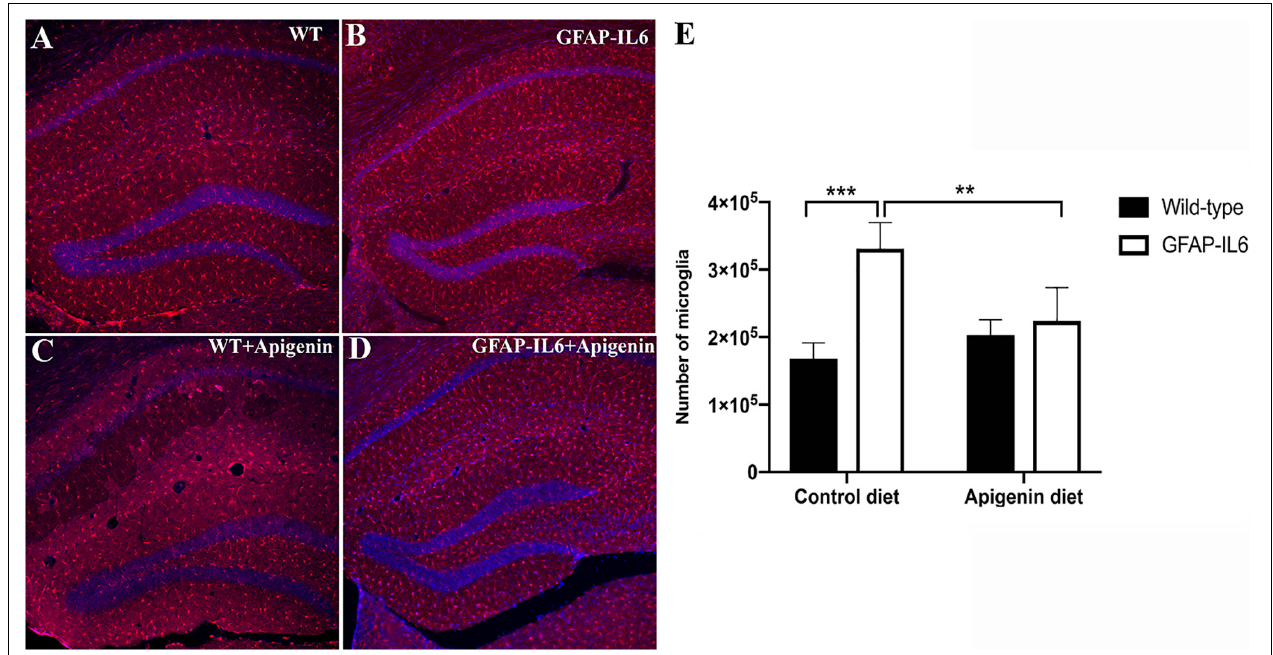
FIGURE 3 | (A–E) Apigenin decreased the number of Iba-1 + microglia in the hippocampus of GFAP-IL6 mice at 22 months of age. (A–D) Representative photographs showing Iba-1 + microglia distribution in the hippocampus in (A) WT standard diet-fed mice, (B) GFAP-IL6 standard diet-fed mice, (C) WT apigenin-fed mice, and (D) GFAP-IL6 apigenin-fed mice. Scale bar represents 200 um. (E) Stereological estimation of total microglia counts in the hippocampus in 22-month-old WT and GFAP-IL6 mice fed control or apigenin-enriched diets. Data presented as mean ± SEM. Post hoc effects of “diet” indicated by asterisk, ** p < 0.005,